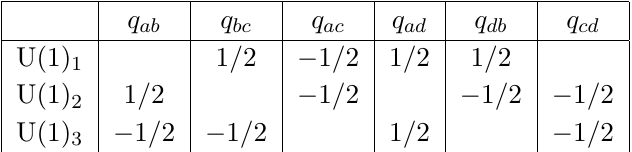
Figure 2 . The quiver diagram for the 3d reduction of the ( A 3 ; A 3 ) theory. Each circle stands for a U(1) vector multiplet, and each edge stands for a hypermultiplet charged under the U(1) gauge symmetries at its ends. Note that this quiver is self-mirror, namely its 3d mirror pair is itself. Therefore, its Coulomb and Higgs branches are isomorphic to each other.